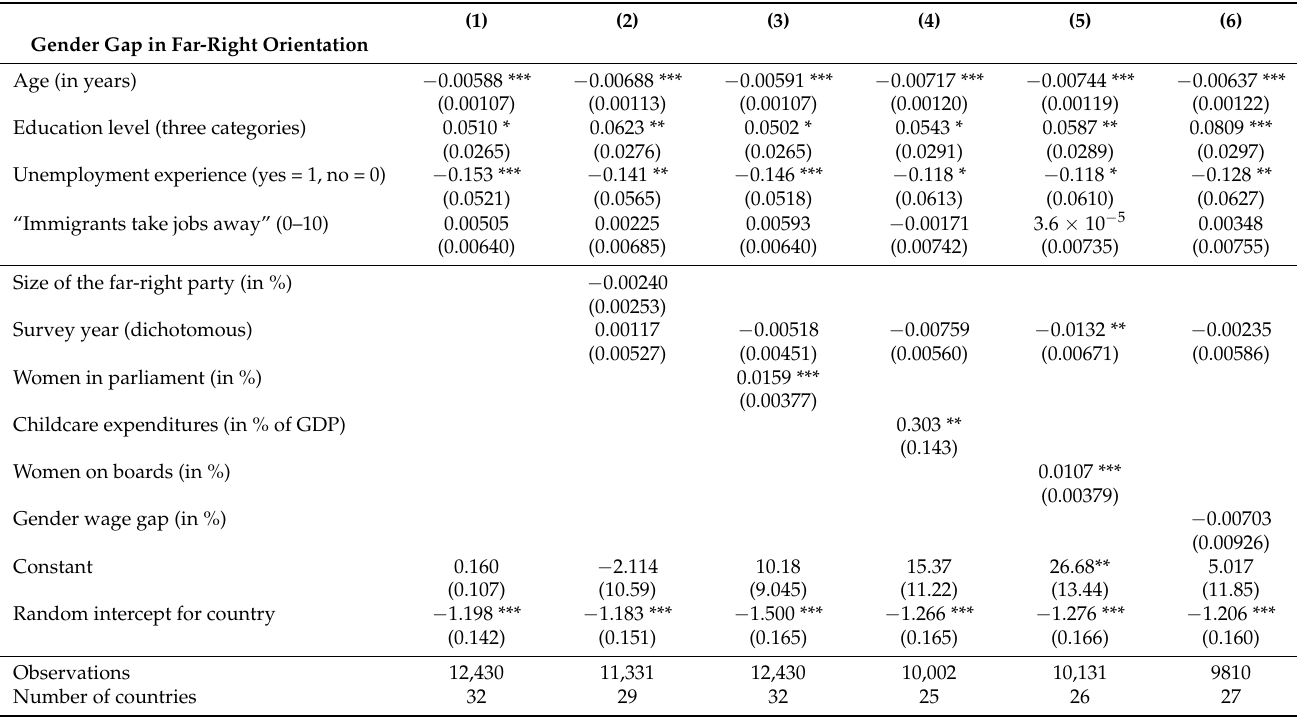
Table 2. Mixed effects logit regression to explain the gender gap in far-right